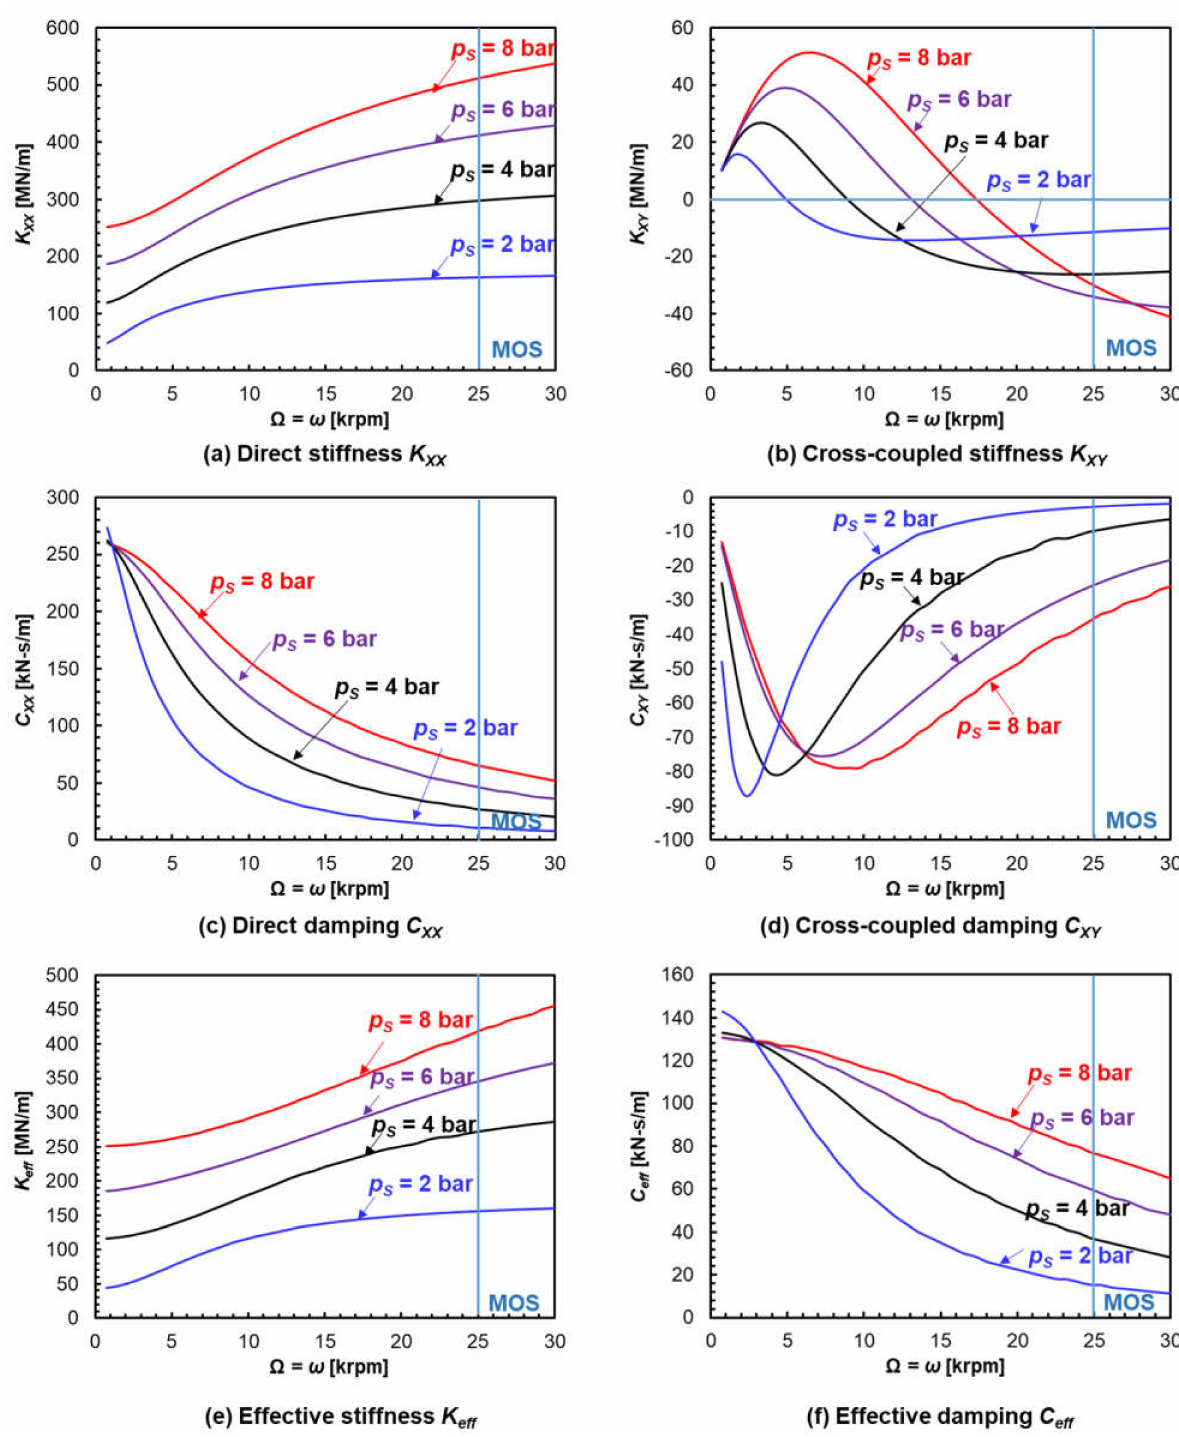
Figure 6. PGB (synchronous frequency) force coefficients vs. shaft speed: ( a , b ) stiffnesses ( K XX , K XY ), ( c , d ) damping coefficients ( C XX , C XY ), ( e , f ) effective stiffness ( K eff ) and damping ( C eff ) coefficients. Excitation frequency ω = Ω (synchronous with speed). Supply pressure p S = 2 to 8 bar; MOS = 25